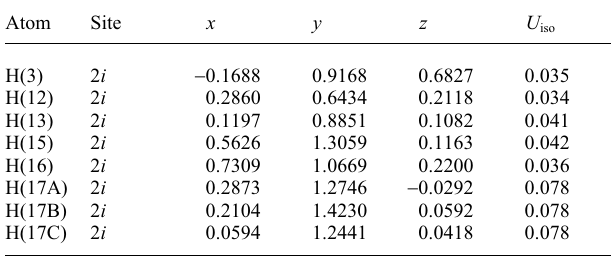
Table 3. Atomic coordinates and displacement parameters (in Å 2 )